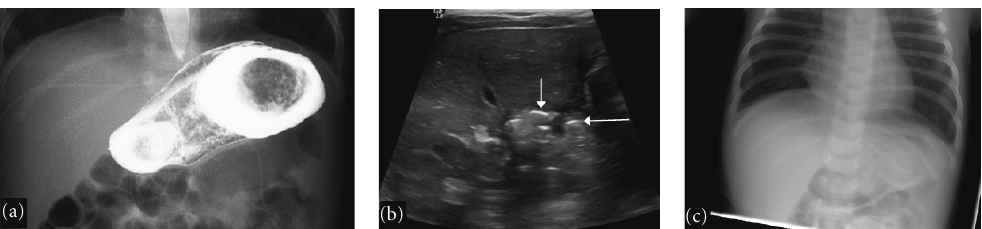
Figure 1: Radiographic findings of a neonatal gastric lactobezoar. (a) Upper GI demonstrating a large filling defect outlining the lumen of the stomach. (b) Sagittal ultrasound of the abdomen showing highly echogenic intrabezoaric air trapping (arrows) within a low echogenic lactobezoar. (c) AP chest X-ray with suggestive findings of a GLB. Intraluminal air outlines an opaque intragastric